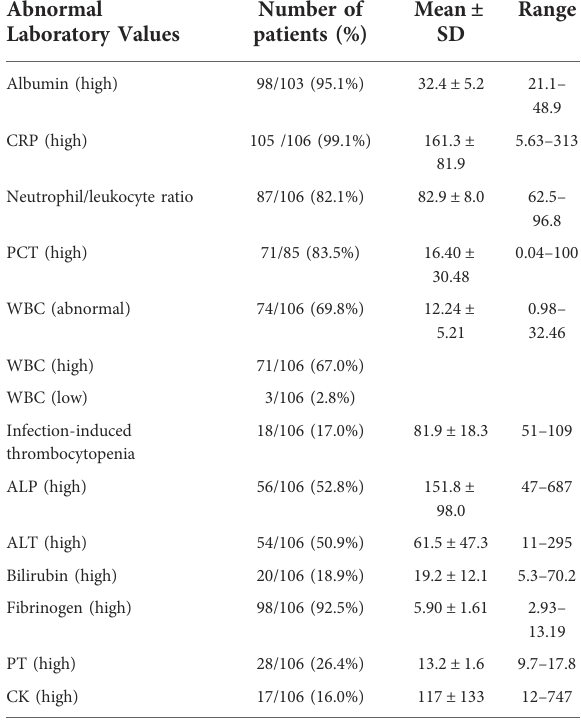
TABLE 1 Clinical features of PLA.